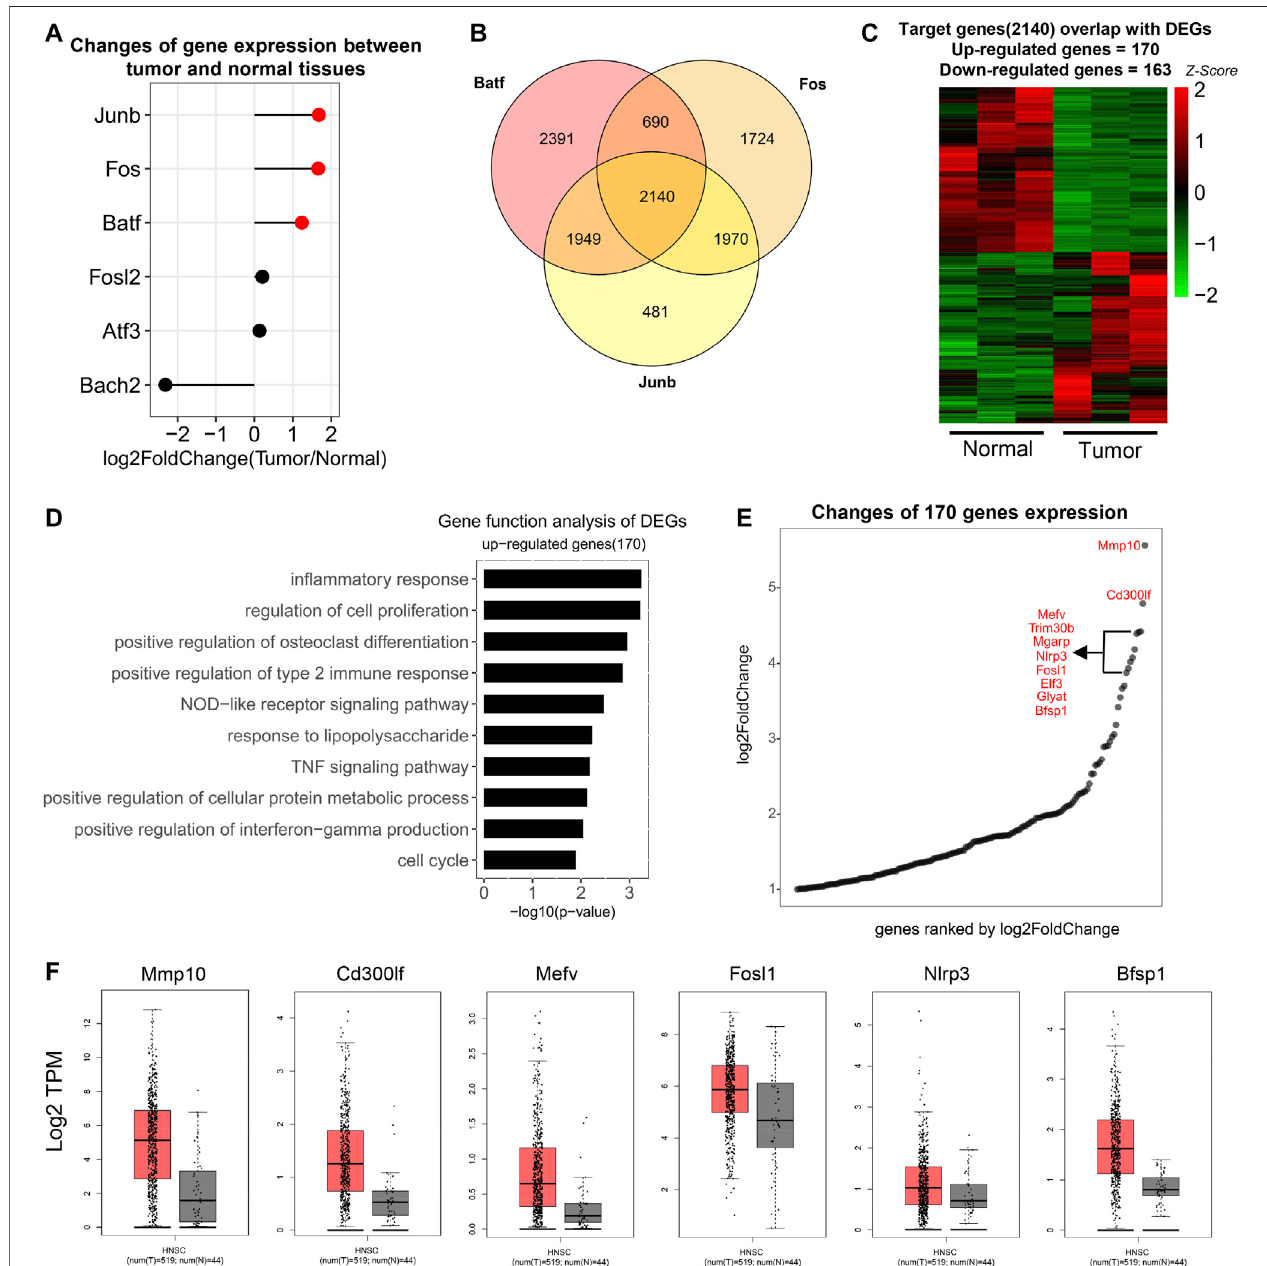
FIGURE 5 | Target genes controlled by AP-1 in HNSCC. (A) Matchstick plot showed the expression change folds of AP-1 family TFs between tumor and normal tissues.TFshighlyexpressedintumorwerehighlightedinred.Cutoff:log2Foldchange ≥ 1. (B) VenndiagramstoshowthenumberofoverlappedgenesamongBatf,Fos, and Junb target genes. Target genes were derived from Cistrome database. (http://cistrome.org/db/#/). (C) Heat map to show the expression of overlapped genes between AP-1 target genes (2,140) and HNSCC DEGs. 170 genes were upregulated and 163 genes were downregulated in tumor ( n (cid:1) 3). (D) Gene function analysisof upregulated AP-1 target genes(170). Itemswere ordered bythe p value. (E) Pointdiagram to show the fold-change (tumor/normal) of170 upregulated AP-1 targetgenes.Geneswererankedbylog2fold-changeandthetop10geneswerelisted. (F) Boxplotstoshowtheexpression(log2TPM)ofthetop10genesin Figure4E in HNSCC tumor and normal tissues in the TCGA database. Only the genes with signi fi cant change were displayed.